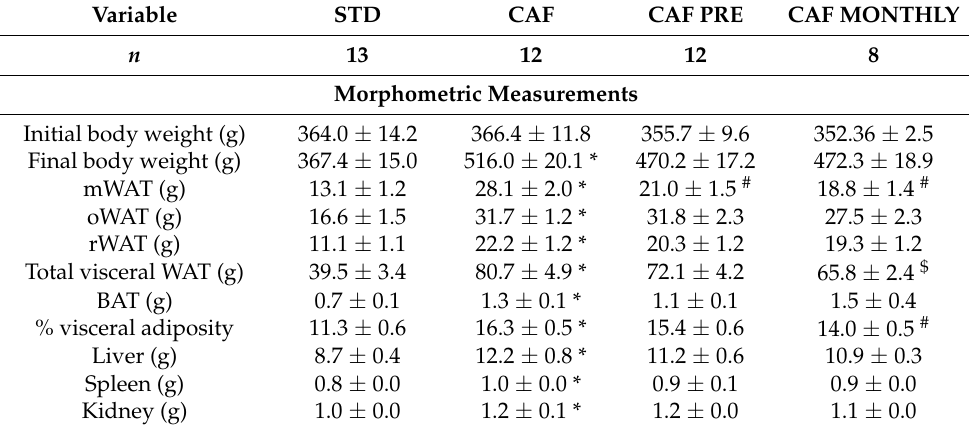
Table 2. Morphometric variables of the groups studied.